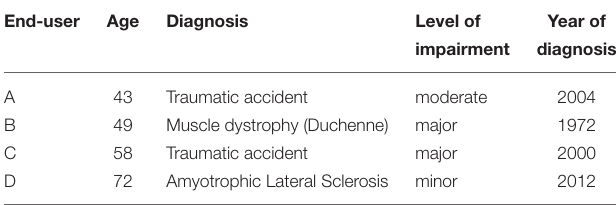
TABLE 1 | End-user participant